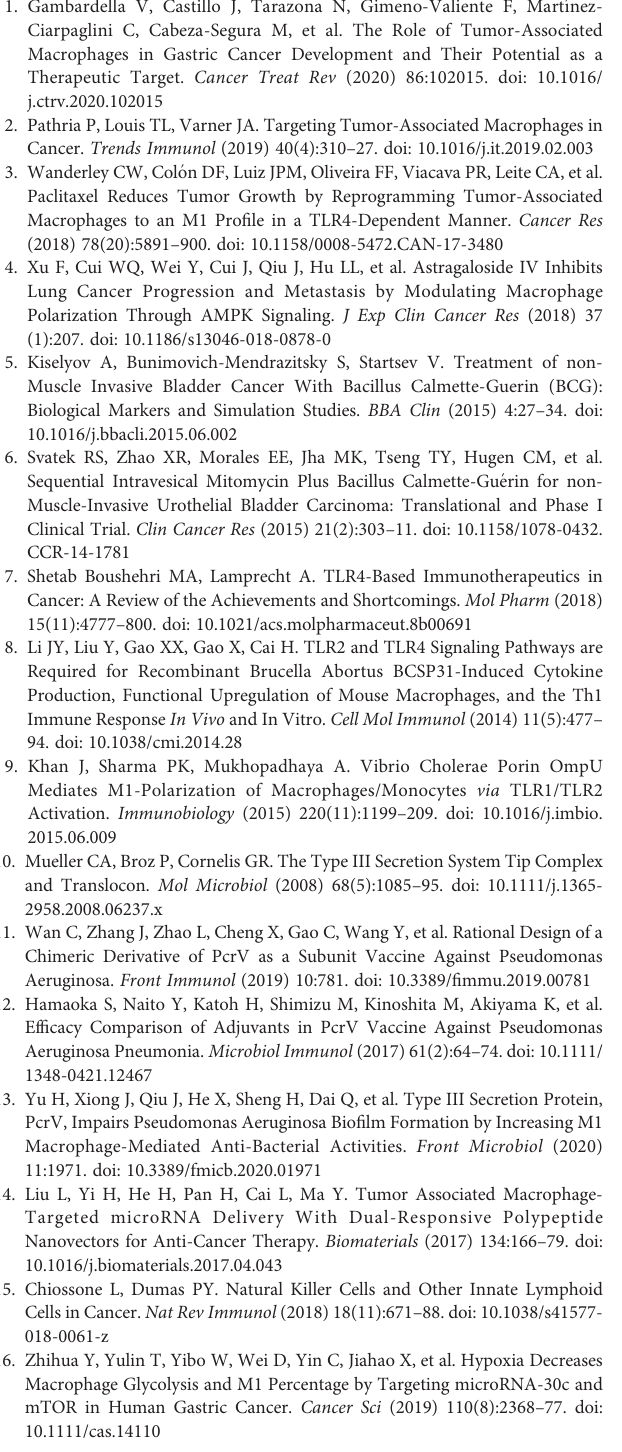
treated with WT, TLR4 -/- or MyD88 -/- BMDMs primed or not with PcrV. Data were expressed as means ± SEM [ (B) , n = 4] or means ± SD [ (C) , n = 4], and were analyzed by two-way ANOVA (B) or unpaired Student ’ s t-test (C) . **P <